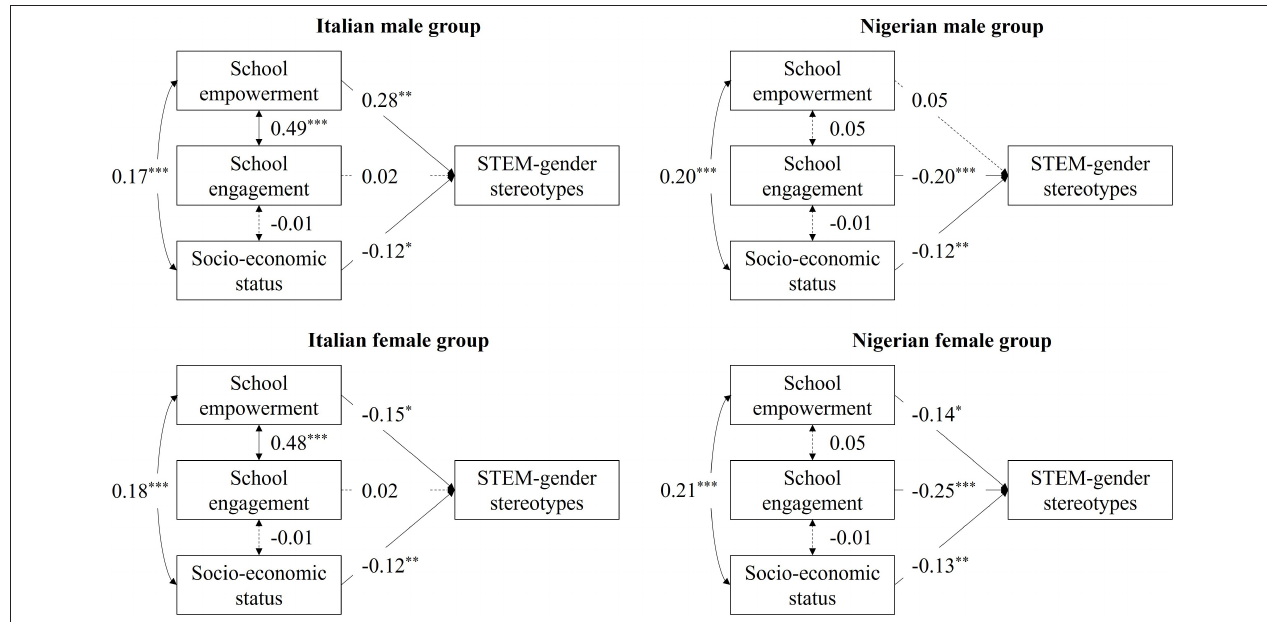
FIGURE 2 | Final estimated multiple-group path model. Solid lines represent significant pathways, dashed lines are non-significant. Standardized regression coefficients (betas) are shown. * p < 0.05, ** p < 0.01, *** p <